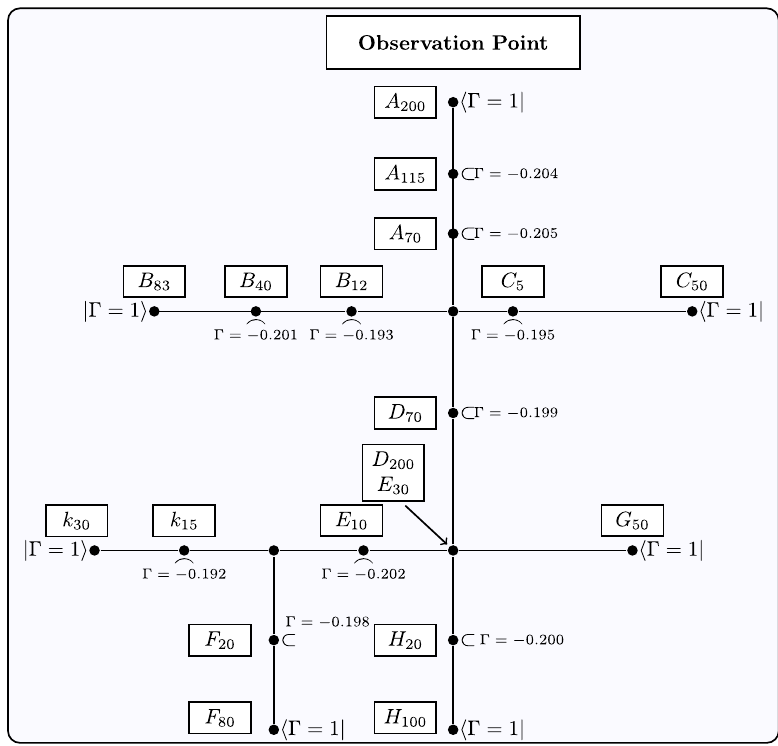
Figure 10. The IEEE 13-bus network. The network is split into Branches A, B, C, D, E, F, G, H and K. Please note that the distances in the diagram are shown in nodes, where one node is equal to 3 m, e.g., branch A is 600 m long, branch B is 249 m, etc.